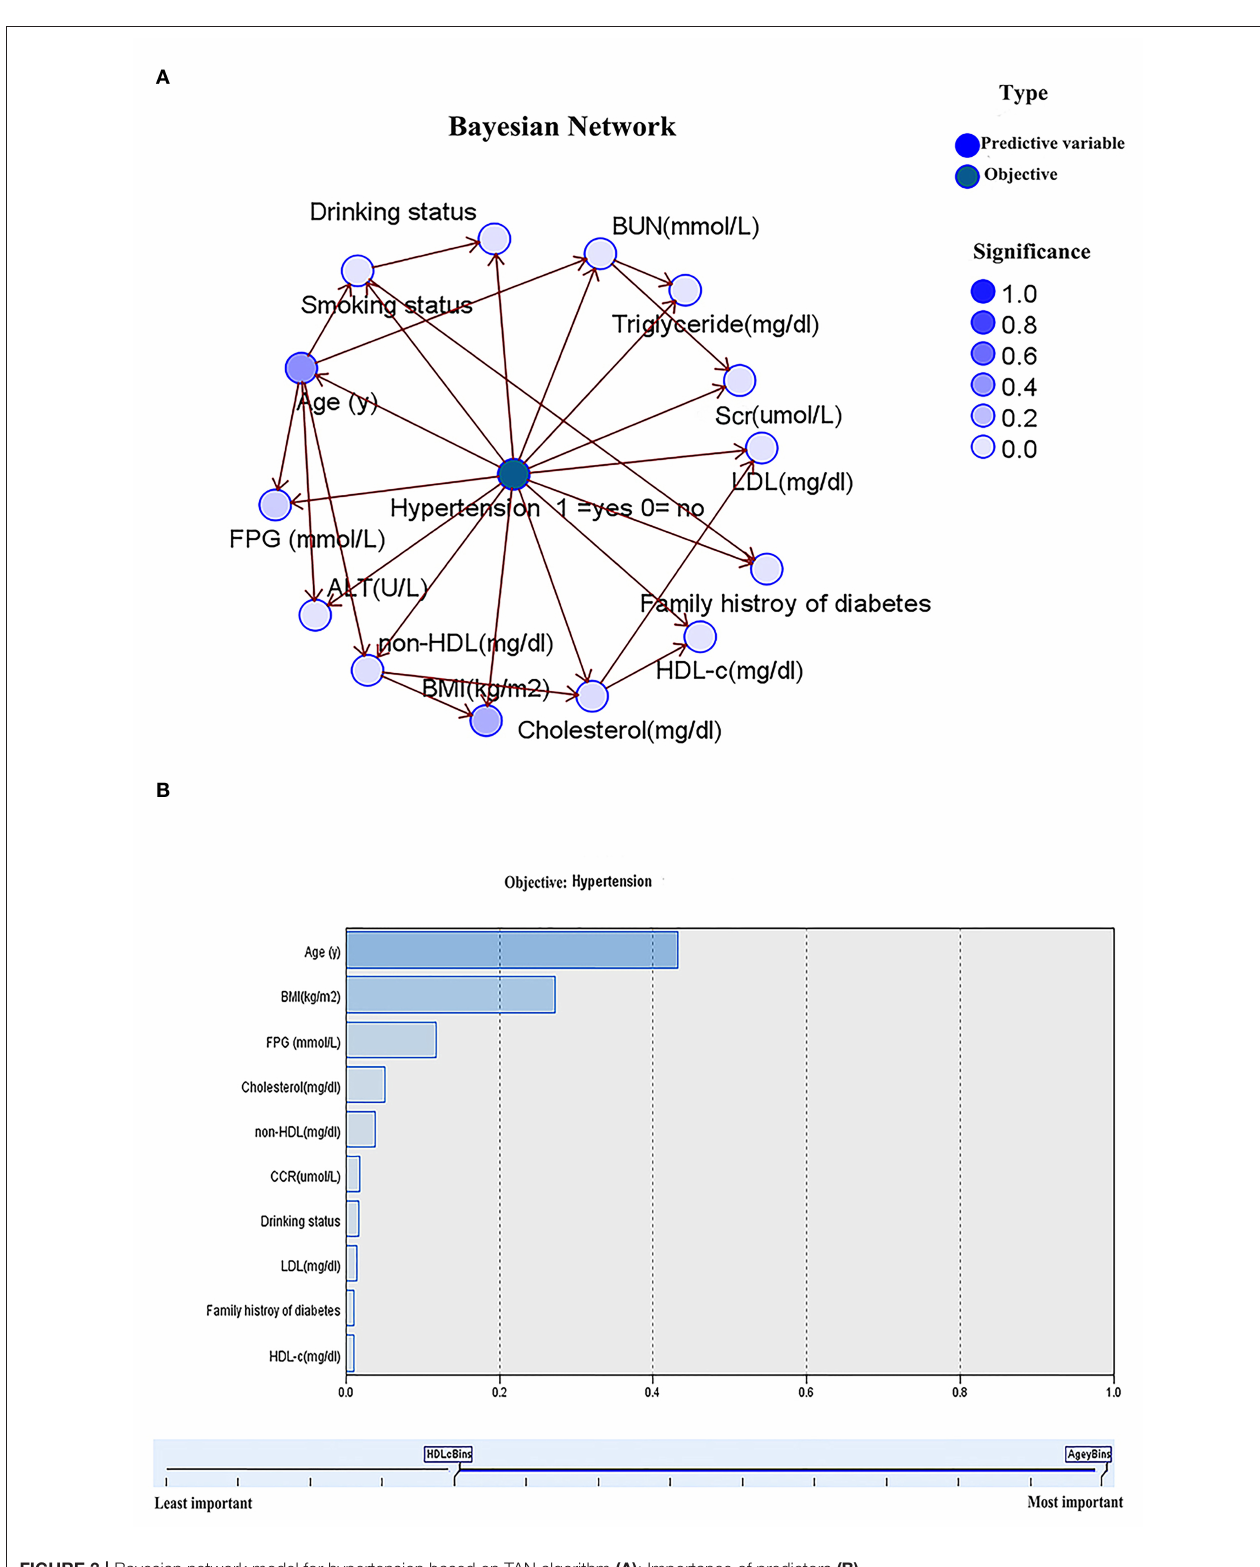
Frontiers in Public Health |